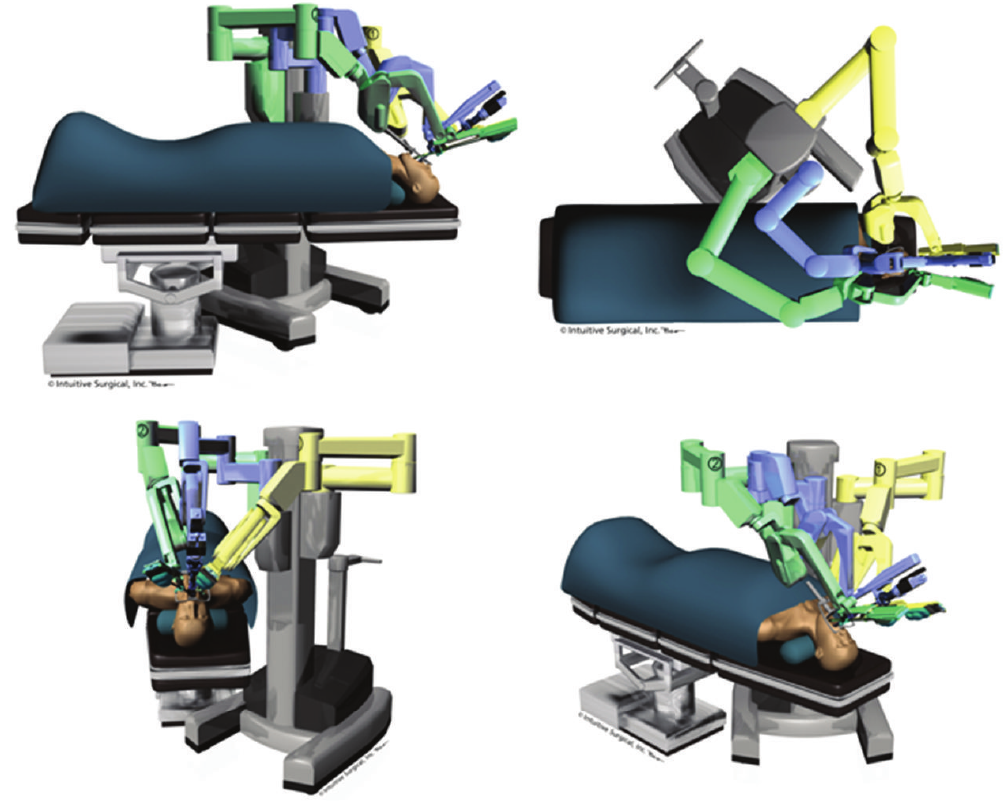
Figure 2: Patient-side cart and robotic arms positioning. (Courtesy of Intuitive Surgical Inc.,